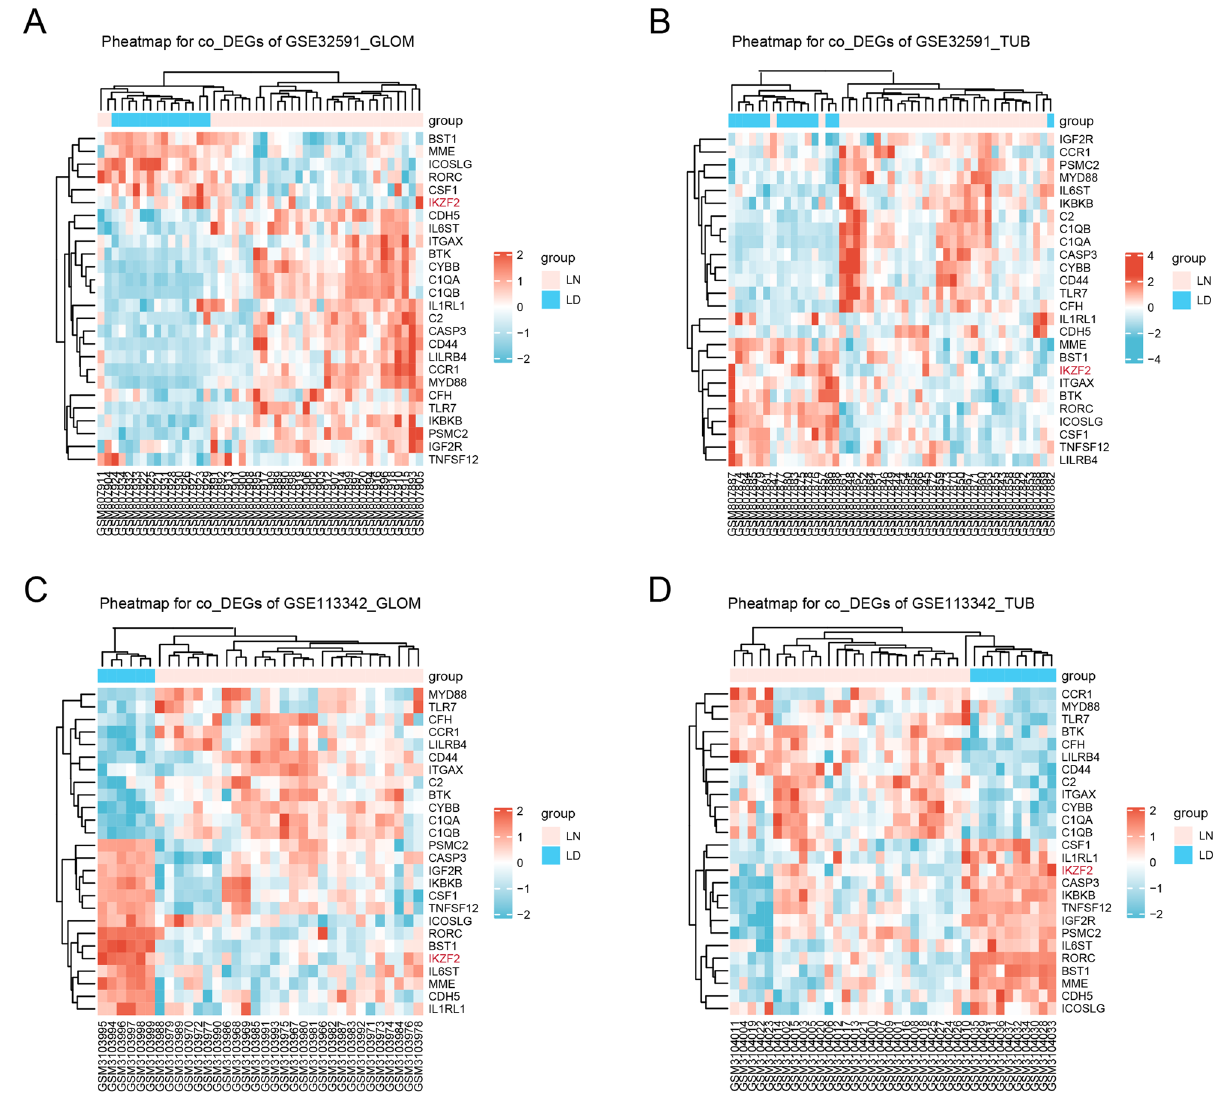
Figure 3. Identifying the correlation between co-DEGs and clinical diagnosis. Heat map of co-DEGs expression from the four sets of data. The abscissa depicted the id of patients and the ordinate denoted 26 co-DEGs. The above pink strip and the blue one represented LN patients and healthy controls respectively. The expression level of co-DEGs were shown in a descending order from red to blue (A-D). The results revealed that the 26 co-DEGs can easily distinguished LN samples from LD. Abbreviation, co-DEGs: common-differentially expressed